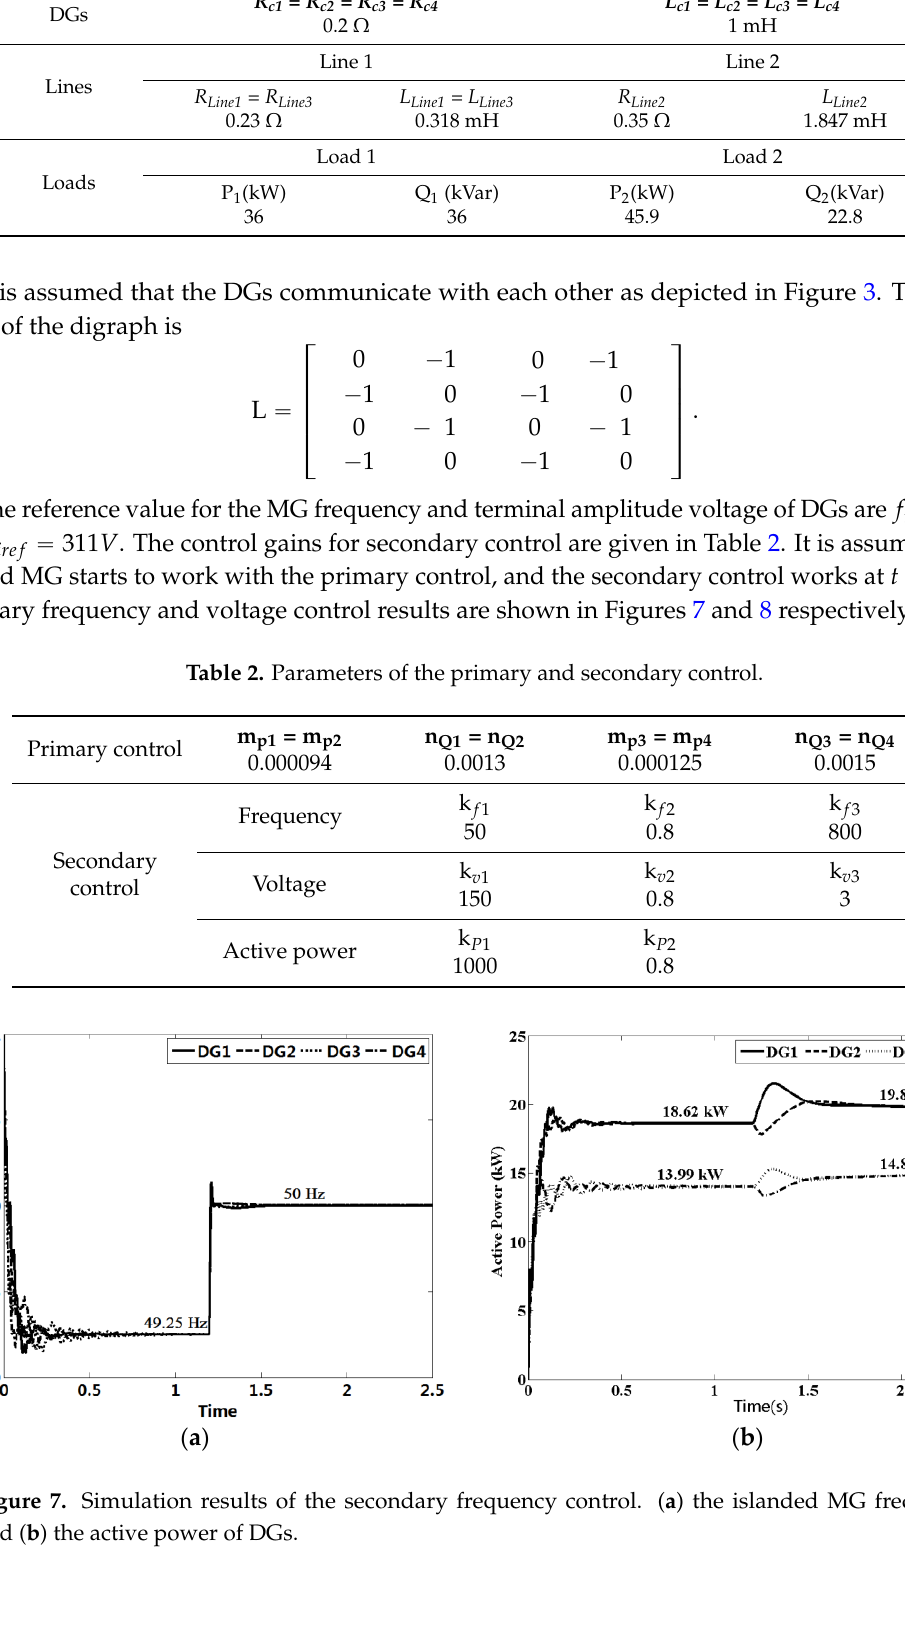
Table 1. Parameters of the MG system.